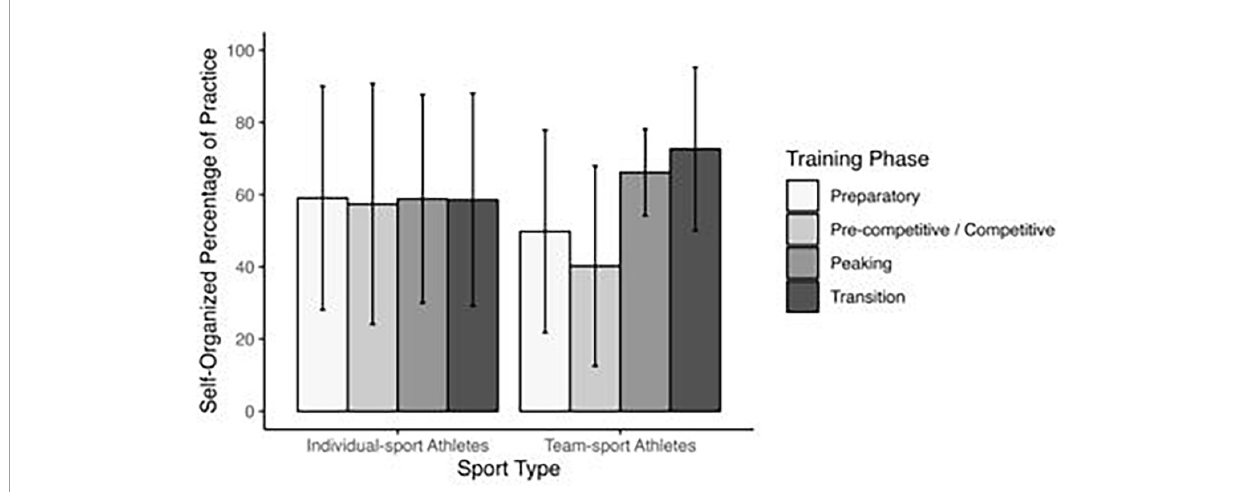
FIGURE4 Means of percentages of self-organized sport practice as a function of athletes’ sport type and phase of season, from Bain et al. (2020). Error bars represent standard deviation.